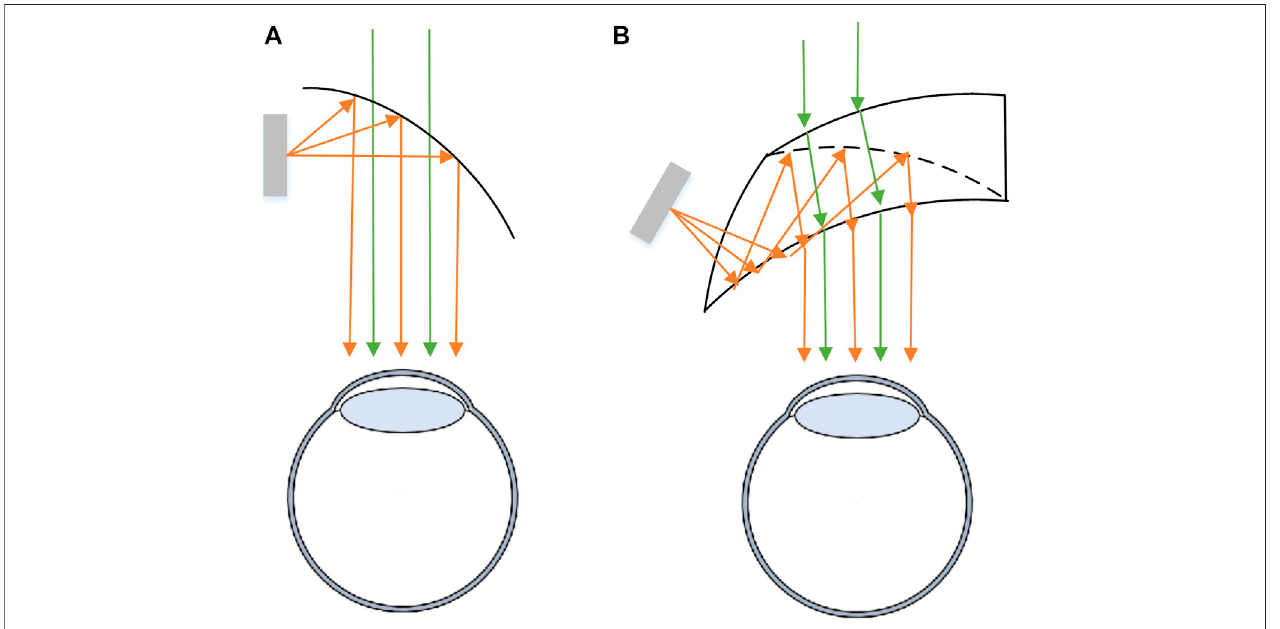
FIGURE 9 | Freeform optics based AR NEDs. (A) : freeform curved half mirror. (B) : freeform prism (Only the central FOV of the NEDs is shown in the